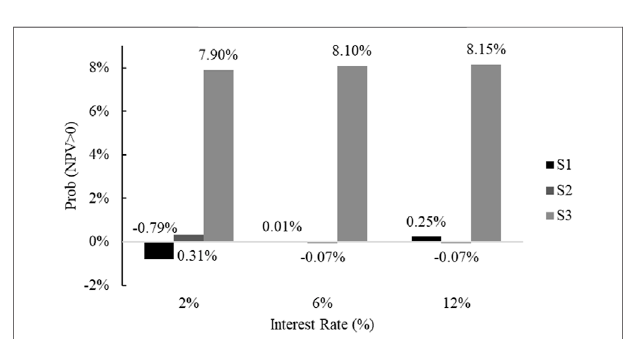
FIGURE 9 | The effect of an interest rate change on the possibility of positive NPV difference of crop rotations with and without carinata.